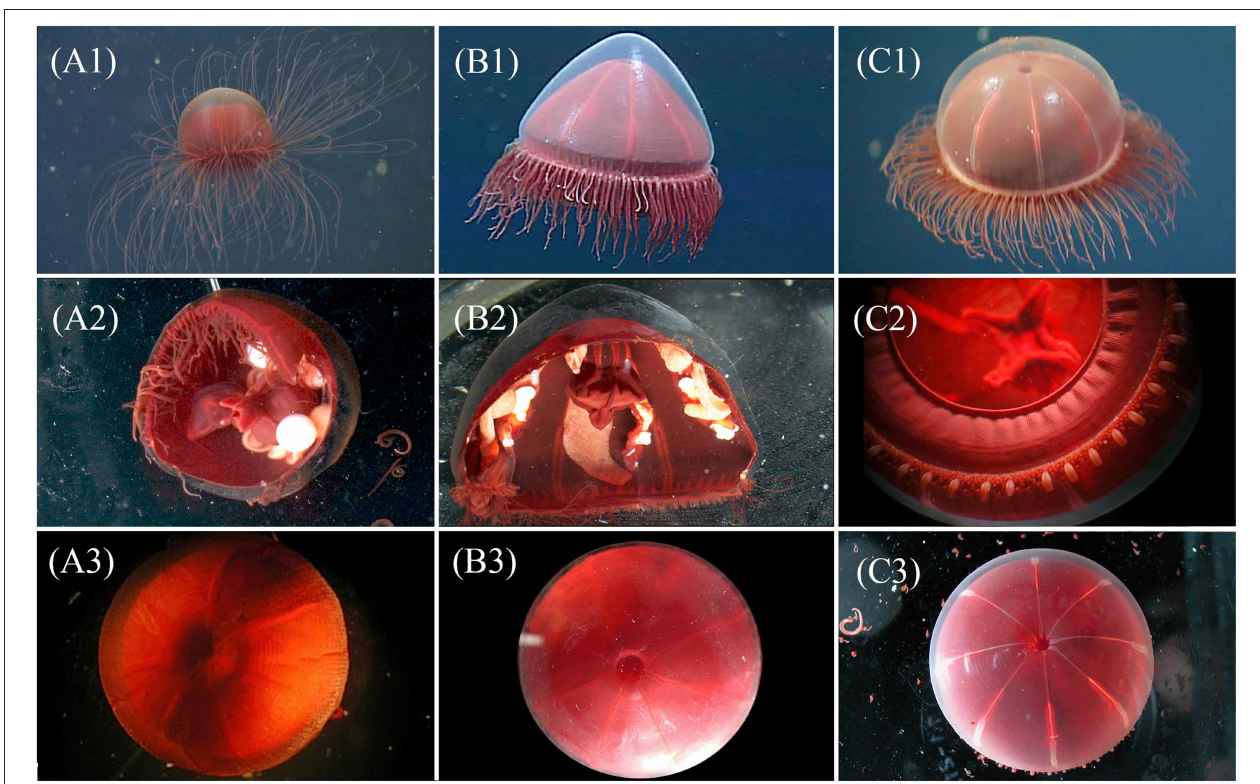
FIGURE 2 | Visual comparison for three genera of “little red jellies” provided for assistance with identification of genera, each image is a unique specimen: Crossota (A1-3) , Pectis (B1-3) , and Benthocodon (C1-3) . Top row, left to right: in situ images for C. rufobrunnea ( A1 —DR457 @ 968m in Monterey Bay), P. profundicola ( B1 —T622 @ 777m in Monterey Bay), and B. pedunculatus ( C1 —T1113 @ 3,483m in Monterey Bay, California) taken by MBARI ROVs. Of the three genera, only Pectis (B1) has centripetal canals and this individual has 8 in each quadrant, irregular in size and just above the canal ring. Row 2 (A2,B2,C2) provides closeup and partial dissections taken in lab for different individuals of C. rufobrunnea ( A2 —T1023SS1 @ 955m in Astoria Canyon, Oregon), P. profundicola ( B2 —T1023SS2 @ 1,117m in Astoria Canyon, Oregon), and B. pedunculatus ( C2 —T623b @ 3,607m in Monterey Bay, California). Note the pendant gonads and absent peduncle of Crossota (A2) , and the semi-pendant gonads and short peduncle for Pectis (B2) . Benthocodon (C2) shows the folded, per-radial lips, tentacular arrangement, and well-developed velum. See Figure 4 for a better view of the peduncle for which Benthocodon pedunculatus is named. Row 3 (A3,B3,C3) provides a dorsal view of the subumbrella region. The subumbrella for C. rufobrunnea ( A3 —T766 @ 1,375m in Monterey Bay, California), unlike both P. profundicola ( B3 —T834SS9 @ 1,384m in Monterey Bay, California), and B. pedunculatus ( C3 —T835SS5 @ 3,285m in Monterey Bay, California), appears closed and does not allow a view through clear mesoglea into the